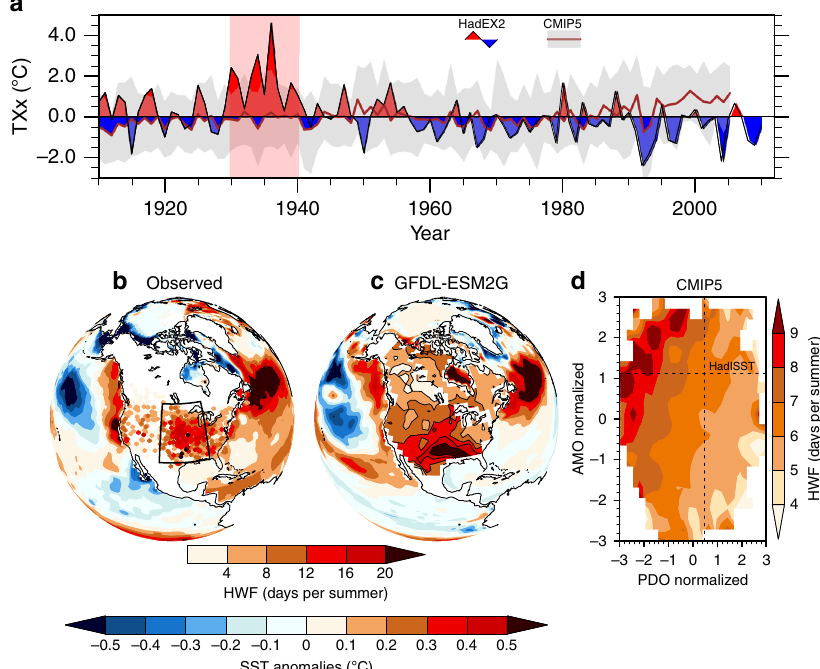
Fig. 1 Observed and simulated central US summer heatwave activity and associated sea surface temperatures. a Observed summer (June – August) maximum daily maximum temperature (TXx) anomalies (relative to 1901 – 2010) averaged over the central US (box in b ), from gridded observations (HadEX2; colour), and 20 Coupled Model Intercomparison Project Phase 5 (CMIP5) historical model simulations (grey line with shading indicating the 10 – 90th percentile range; relative to 1901 – 2005). b , c Summer sea surface temperature anomaly and heatwave frequency (HWF) patterns averaged across the most active heatwave summer decade (11 years) per century over the central US for station observations ( b ; pink shade in a ), and a selected CMIP5 model (Geophysical Fluid Dynamics Laboratory Earth System Model with Generalised Ocean Layer Dynamics component, GFDL-ESM2G) decade with heatwave activity commensurate with observations ( c ). d Composite anomalies of central US summer HWF as a function of the normalised annual Paci fi c Decadal Oscillation (PDO) and Atlantic Multidecadal Oscillation (AMO) indices, from 22 CMIP5 pre-industrial (pi) Control experiments totalling 10,900 years (1930s decadal observations shown as the intersect of dotted lines). The PDO and AMO de fi nition are described in the ‘